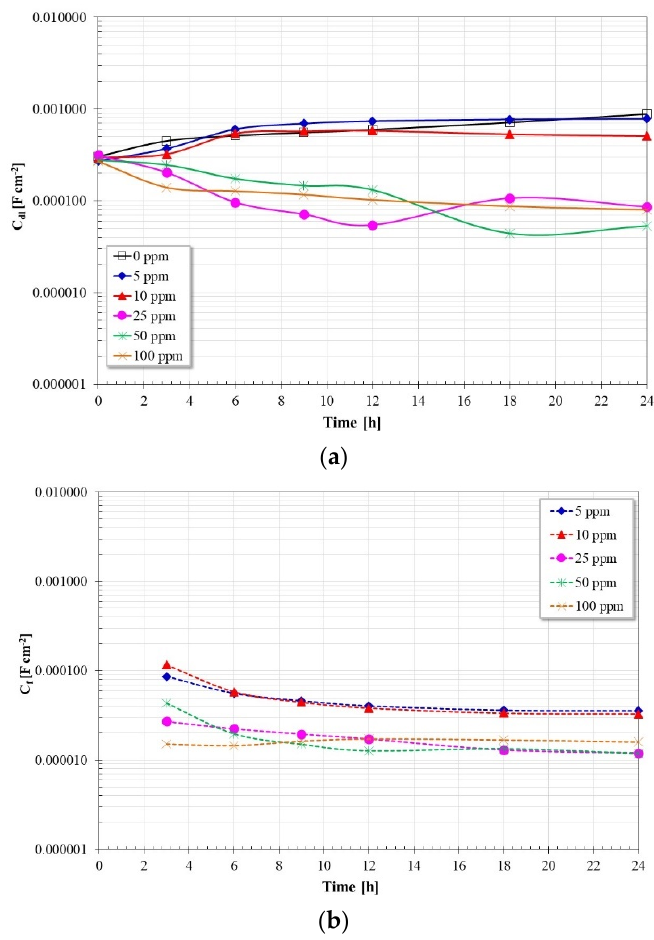
Figure 10. Cdl and Cf values as a function of time and inhibitor concentration.